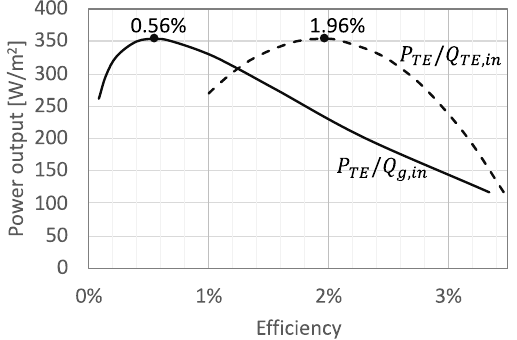
Figure 8. Power output and TE conversion efficiency as a function of the heat capacity ratio between the water and gas, with the water flow rate fixed at C w = 0.05 kg/s.